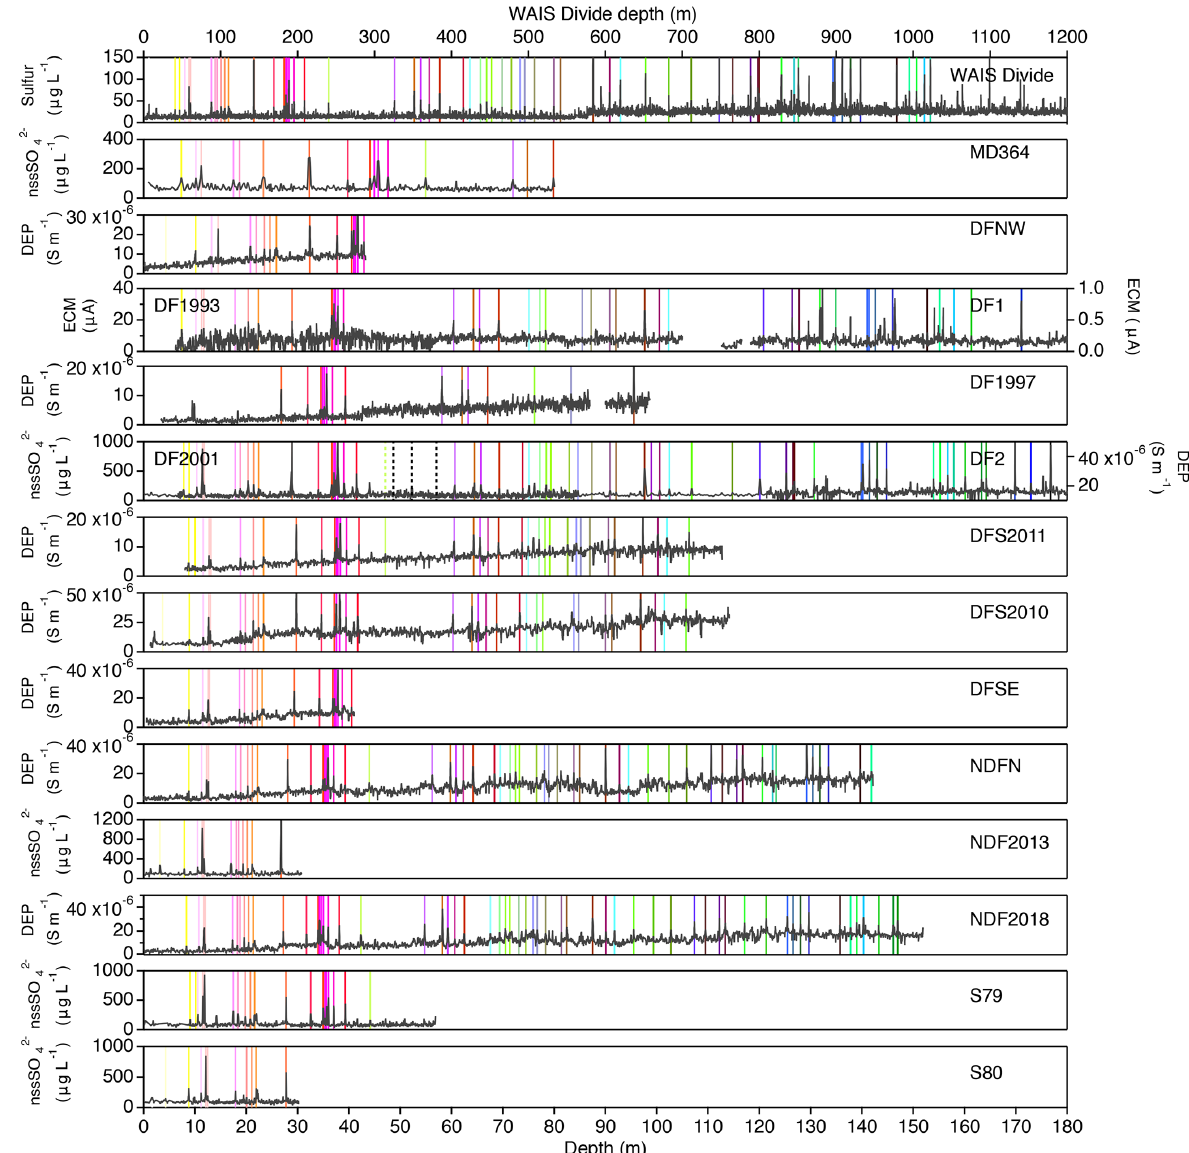
Figure B1. The same data and colored lines as Fig. 3 but plotted against depth.